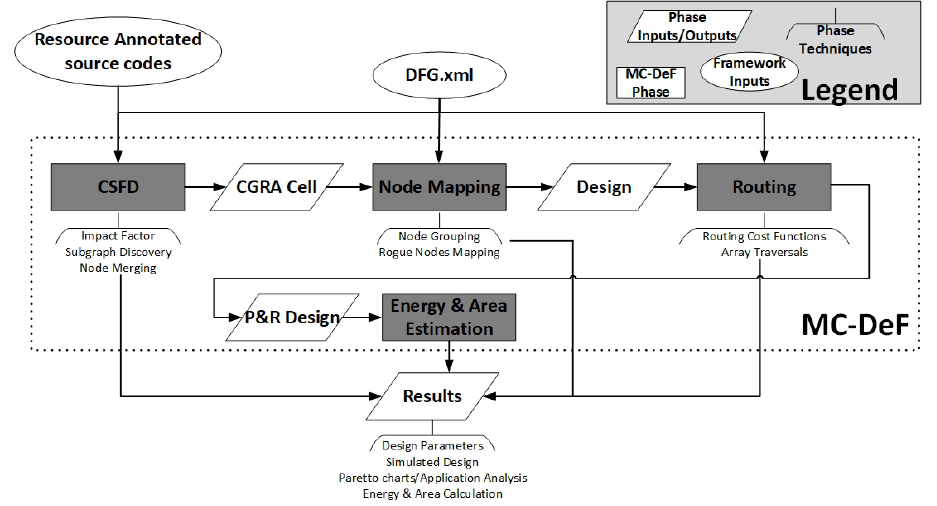
Figure 4. The MC-DeF flow with its associated phases and